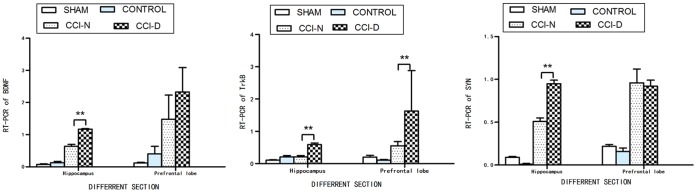
The effect on mRNA levels after rhGH treatment.(a). BDNF mRNA levels (left). (b). TrkB mRNA levels (middle). (c). SYN mRNA levels (right). Note: ** indicated as P<0.05 between the two groups.